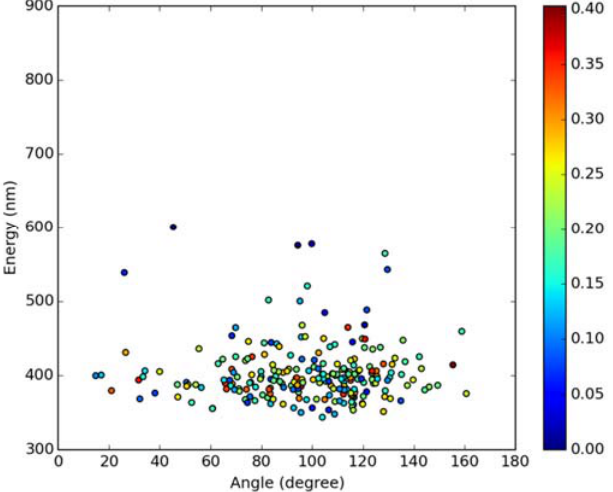
Figure 12. Emission energy vs fluorophore tilt angle in DPPC bilayer. Oscillatory strength is color ‐ coded.